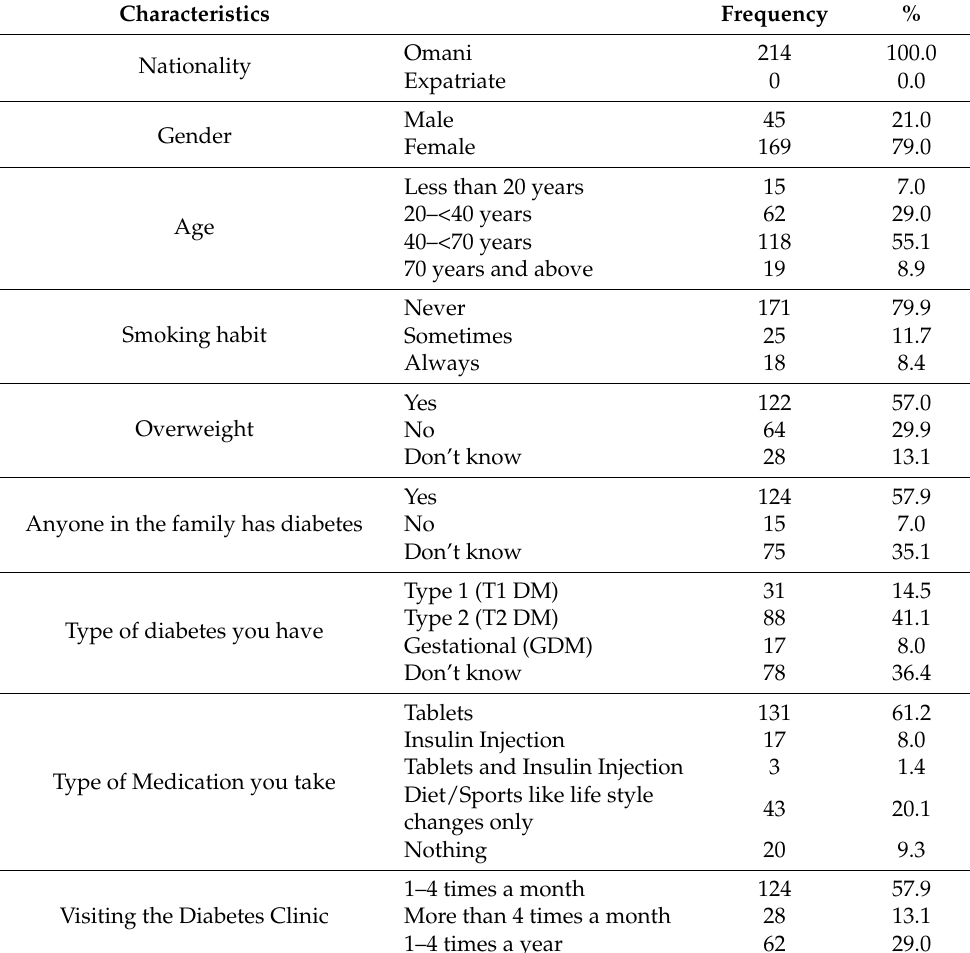
Table 1. Demographic details of the